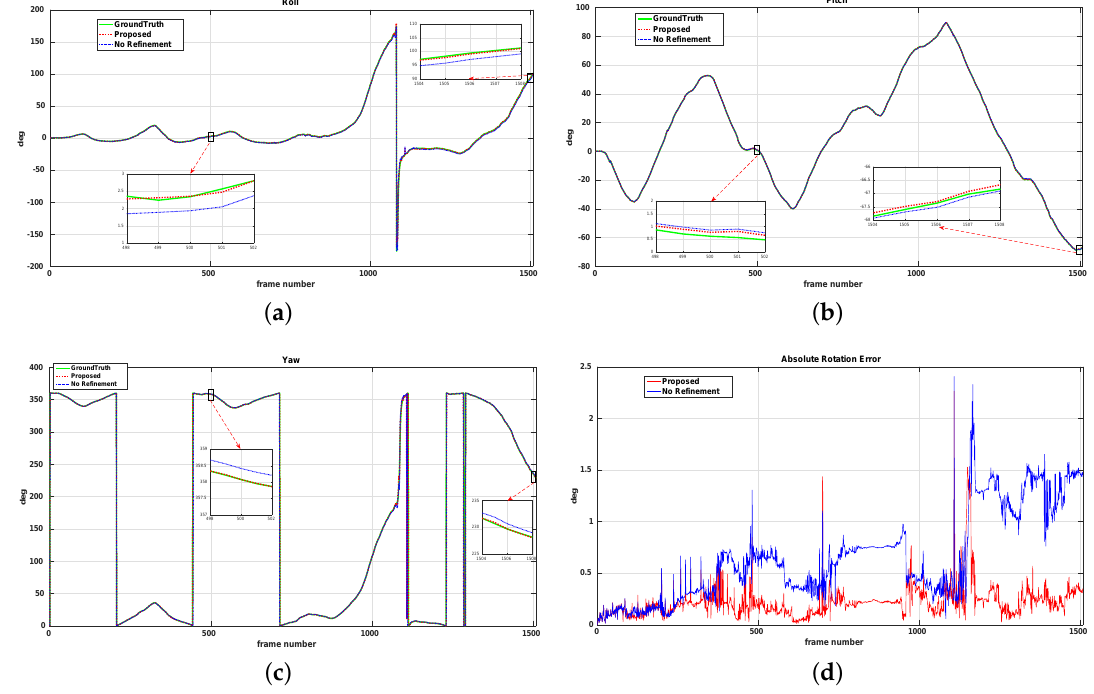
Figure 7. Performance evaluation for refinement on the ’Living Room 0’ sequence: ( a – c ) Roll, pitch, and yaw angles estimated by the proposed method with and without a refinement step for each frame. ( d ) Absolute rotation errors for our proposed methods with and without a refinement step. This shows that the refinement step can effectively reduce rotation drift.